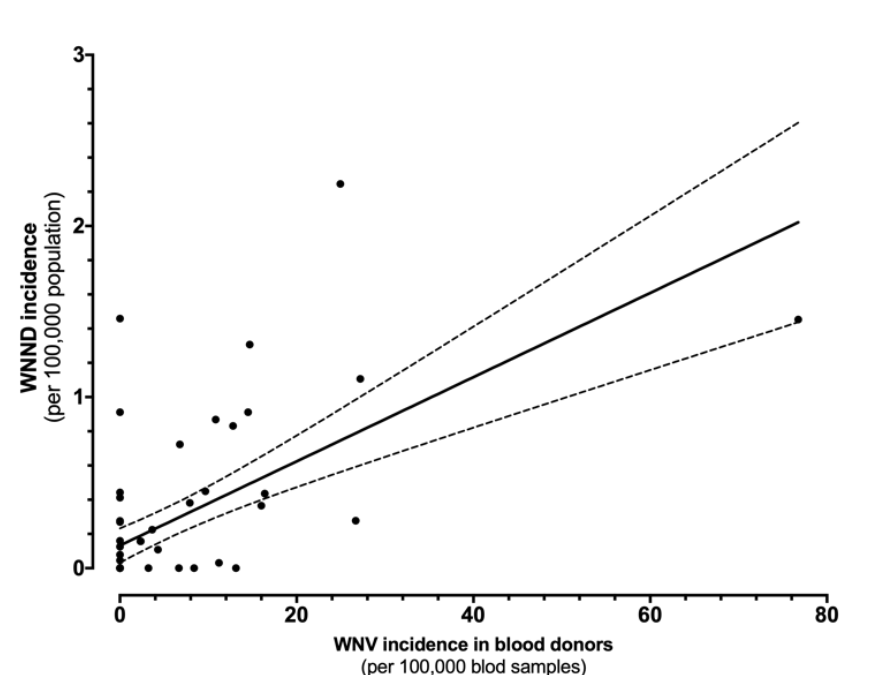
Figure 5. Correlation between the incidence of cases of West Nile virus (WNV) infections in blood samples and West Nile neuro-invasive diseases (WNND) in the corresponding index areas (r = 0.617, p < 0.001).